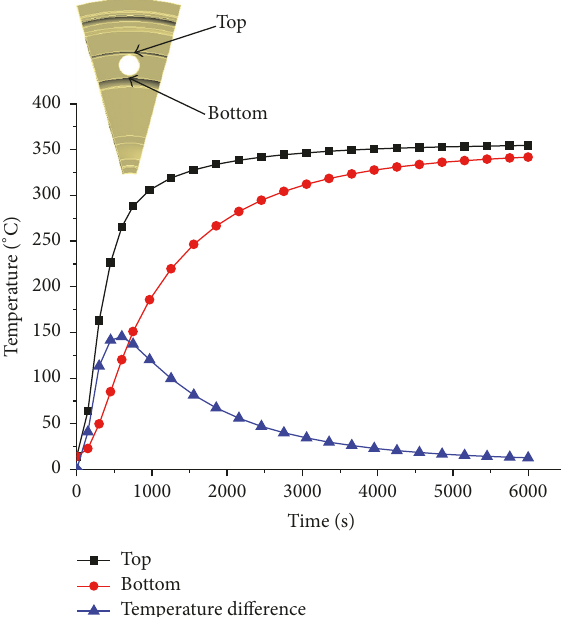
Figure 11: Temperature variation of the 13th compressor tie rod hole during start-up period.